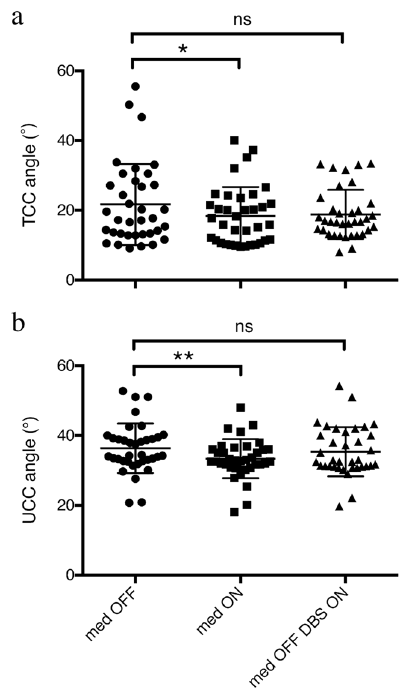
Fig. 1 Effect of levodopa and surgery on camptocormia angles in the whole population. Pre- and post-surgical total- ( a ) and upper ( b ) camptocormia angles (TCC/UCC angles) were shown for individual PD patient. * p < 0.05; ** p < 0.01; n.s.: not signi fi 25.4° ± 5.7° to 22.7° ± 9.1°, p = 0.4114). In patients without camptocormia, improvement in the TCC angles (from 15.9° ± 5.4° to 14.9° ± 5.1°, p = 0.0689) was not signi fi cant, whereas a small but